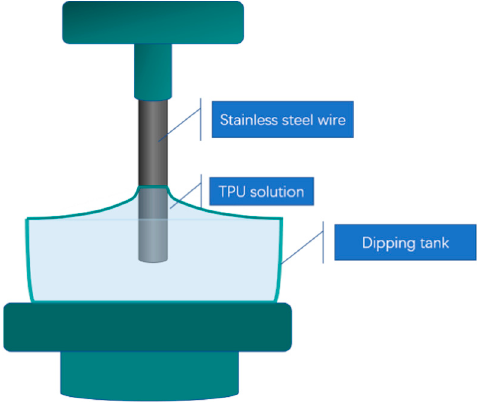
Figure 2. Schematic diagram of the dip- coating process.